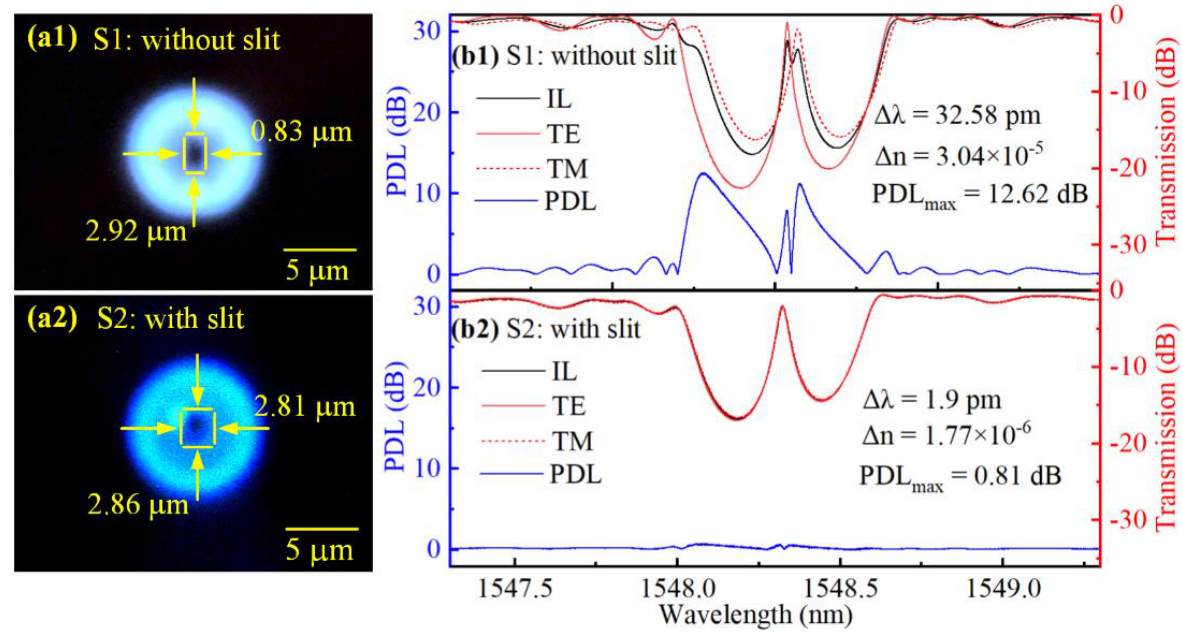
Figure 8. Two FBG-FPs inscribed without slit beam shaping (i.e., S1) and with slit beam shaping (i.e., S2). ( a ) Cross-sectional-view microscope images and ( b ) corresponding spectra of transmission, two orthogonal linear polarization modes (TE and TM), and PDL.